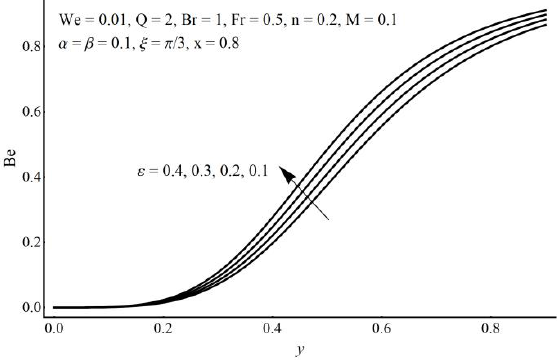
Figure 18. Effect of ε on the Bejan number.